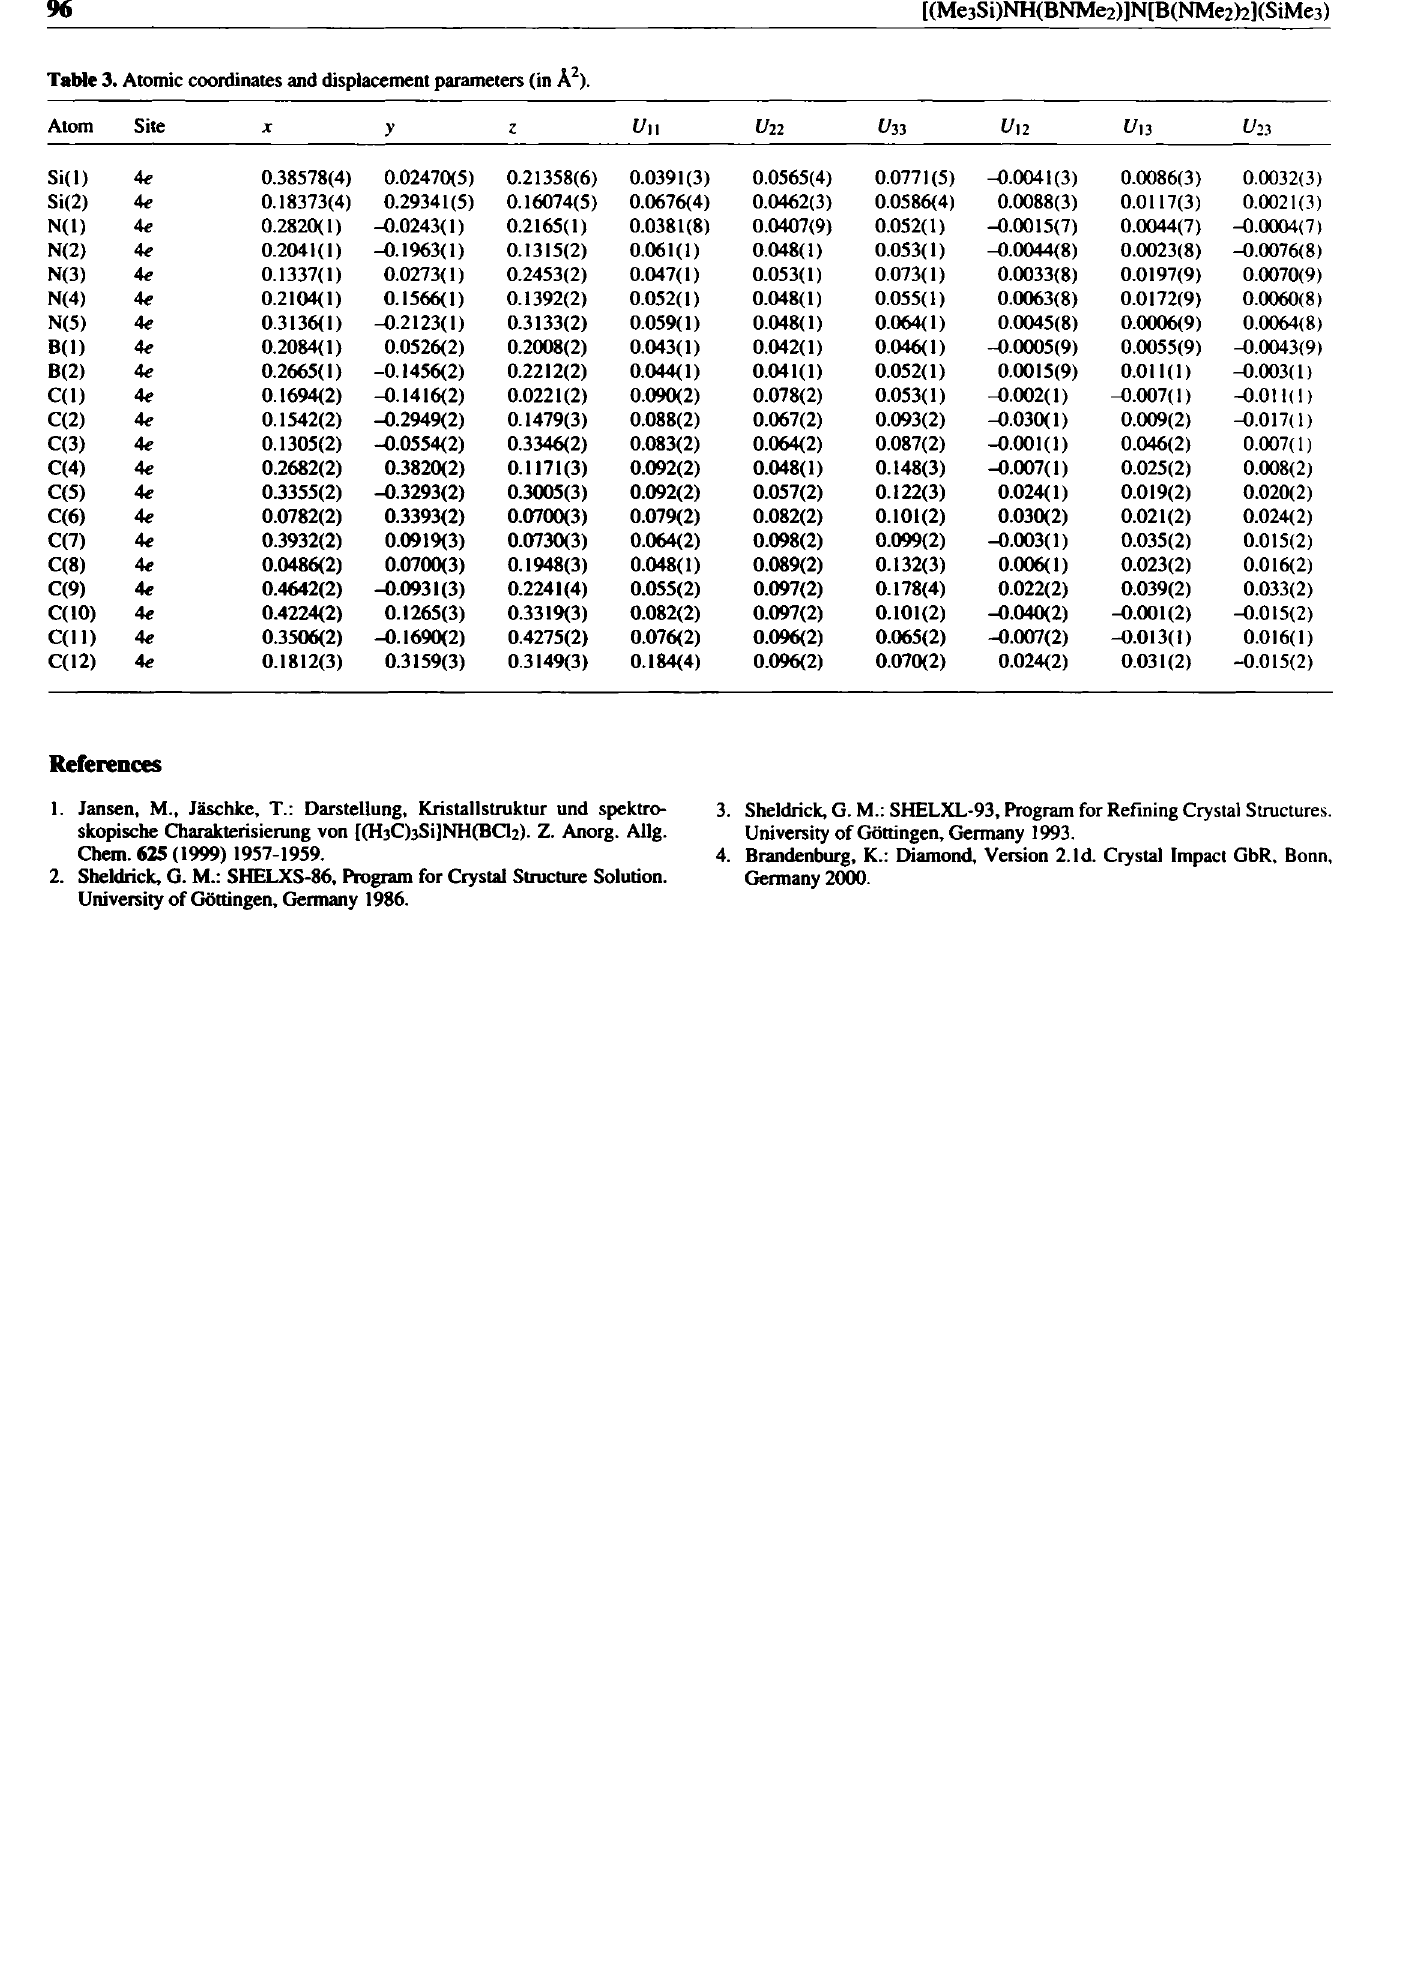
Table 3. Atomic coordinates and displacement parameters (in Â 2